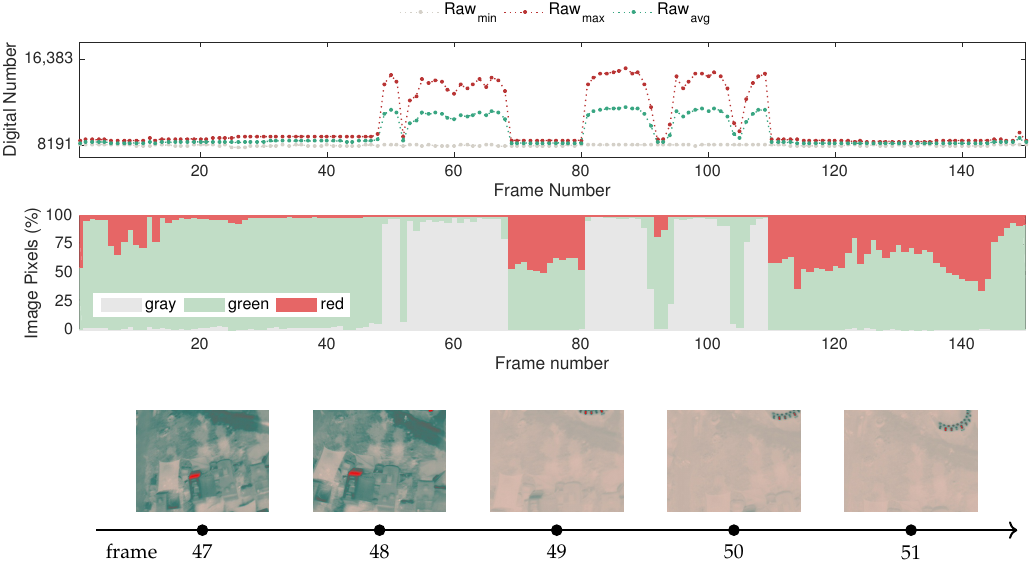
Figure 20. Results for data acquired when surveying the community kitchens area: raw features ( top ); color features ( center ); sample frames ( bottom